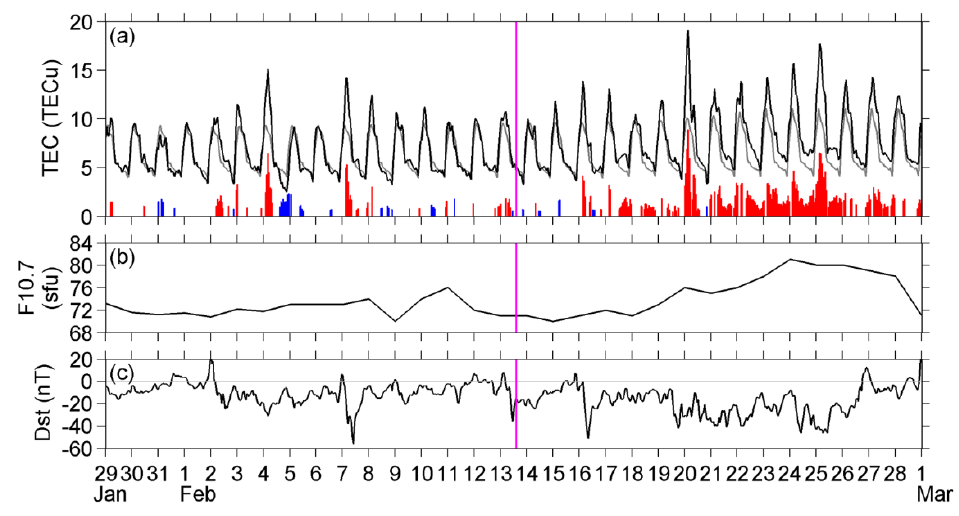
Figure 16. Temporal variation of TEC value for the first February EQ ( a ). The grey lines indicate the mean during the past 30 days. The red and blue bars indicate positive and negative anomalies, respectively; and only anomalies greater than 2 sigma are plotted. Additionally, solar flux (F10.7) ( b ) and the Dst index ( c ) are plotted.